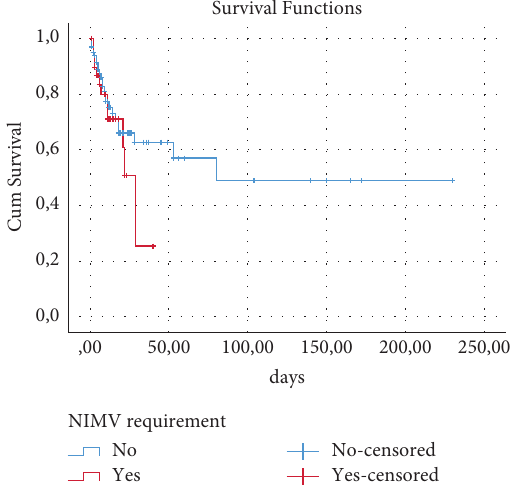
Figure 3: Kaplan–Meier survival analysis by noninvasive mechanic ventilation requirement. Comparison between patients who died in IMCU and the others in NIMV, noninvasive mechanic ventilation requirement.